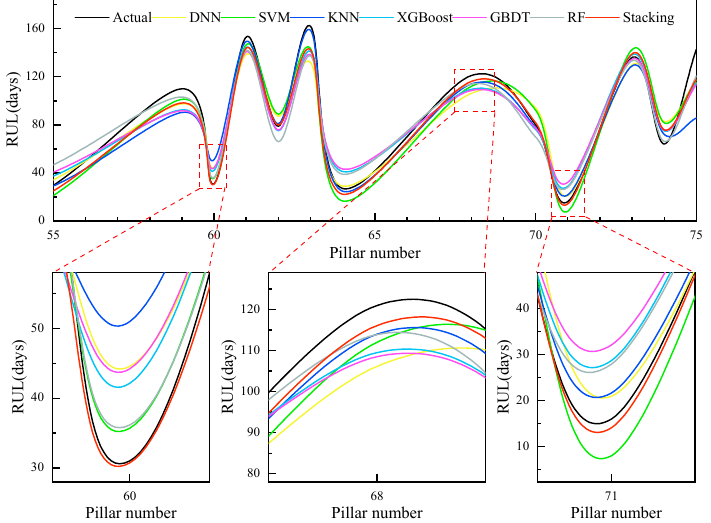
Figure 12. Comparison of predicted and actual values for DNN, SVM, KNN, XGBoost, GBDT, RF and stacking. and